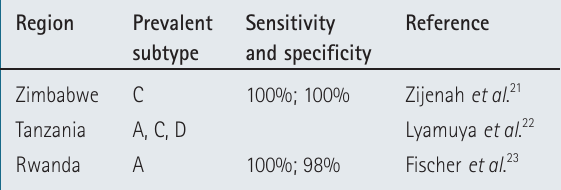
TABLE I. SUMMARY OF PERFORMANCE OF ROCHE